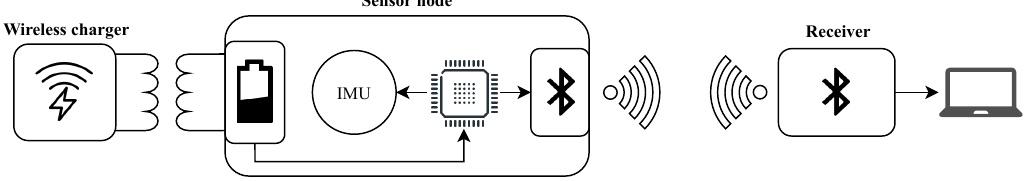
Figure 1. Overview of the hardware: The sensor node built around an Inertial Measurement Unit (IMU), wirelessly rechargeable and with wireless connectivity to a receiver base station.